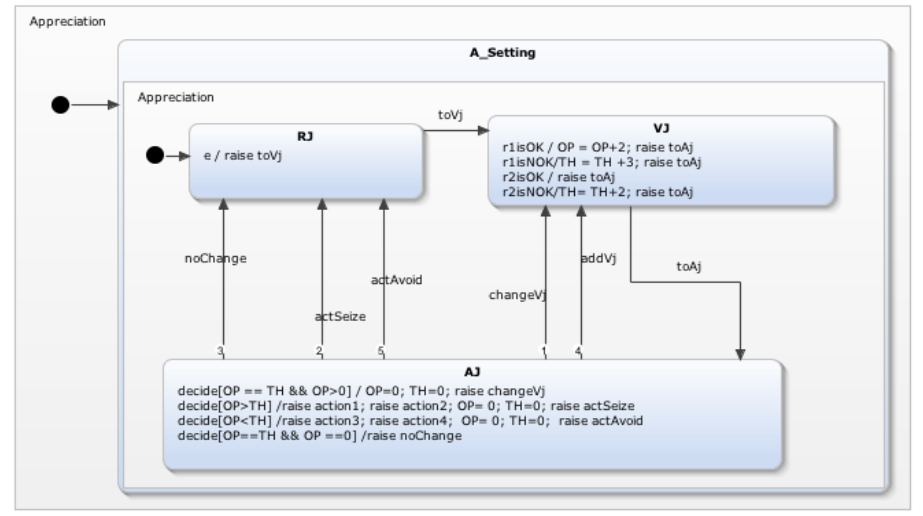
Figure 6 . A generic appreciative model